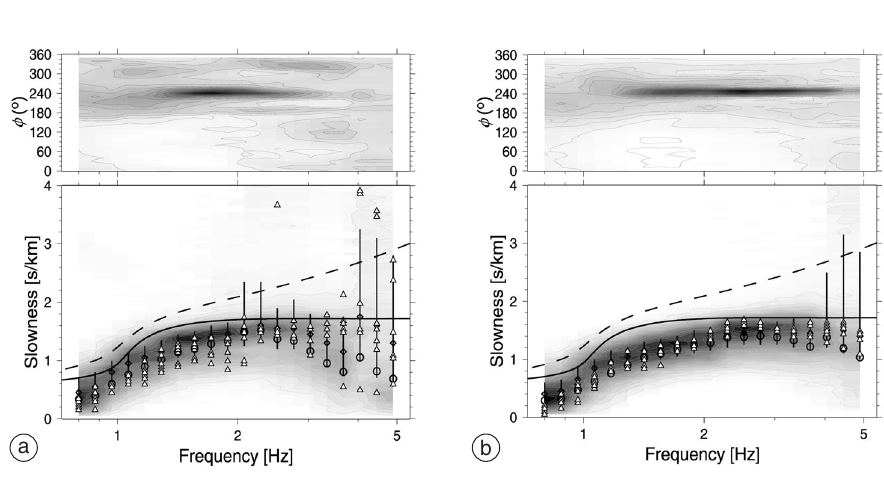
Fig. 5a,b. Source azimuth and dispersion curve of array A (a) and B (b). The results of the FK methods are shown in a histogram-contour plot of slowness maxima for each frequency taken from the FK spectra of indi- vidual analysis windows. The median (black diamond with the 75% and 25% quantile as given by the error bars) and mean (black circle) are plotted. The white triangles are the slowness estimates calculated by Capon’s method. The black curves represent the dispersion curve of the site obtained by forward calculation. The solid one was determined from the geological model after Kind (2002) and the dashed one was calculated based on the power law velocity depth